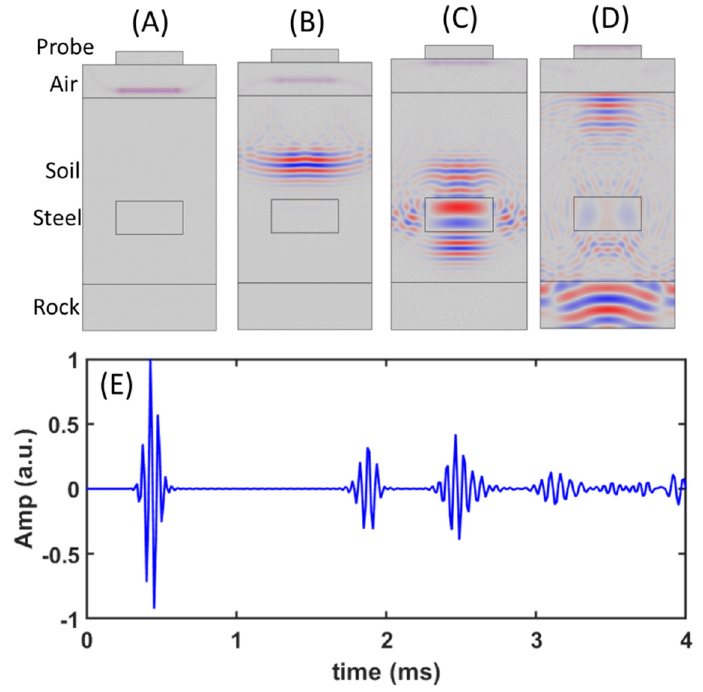
Figure A1. ( A – D ) Various time points of an additional case with steel block embedded into the soil layer, which could be clearly recognized. ( E ) Time of flight signal of the case.